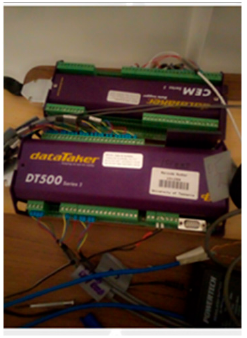
Figure 6. Data acquisition system (DT 500 datalogger).